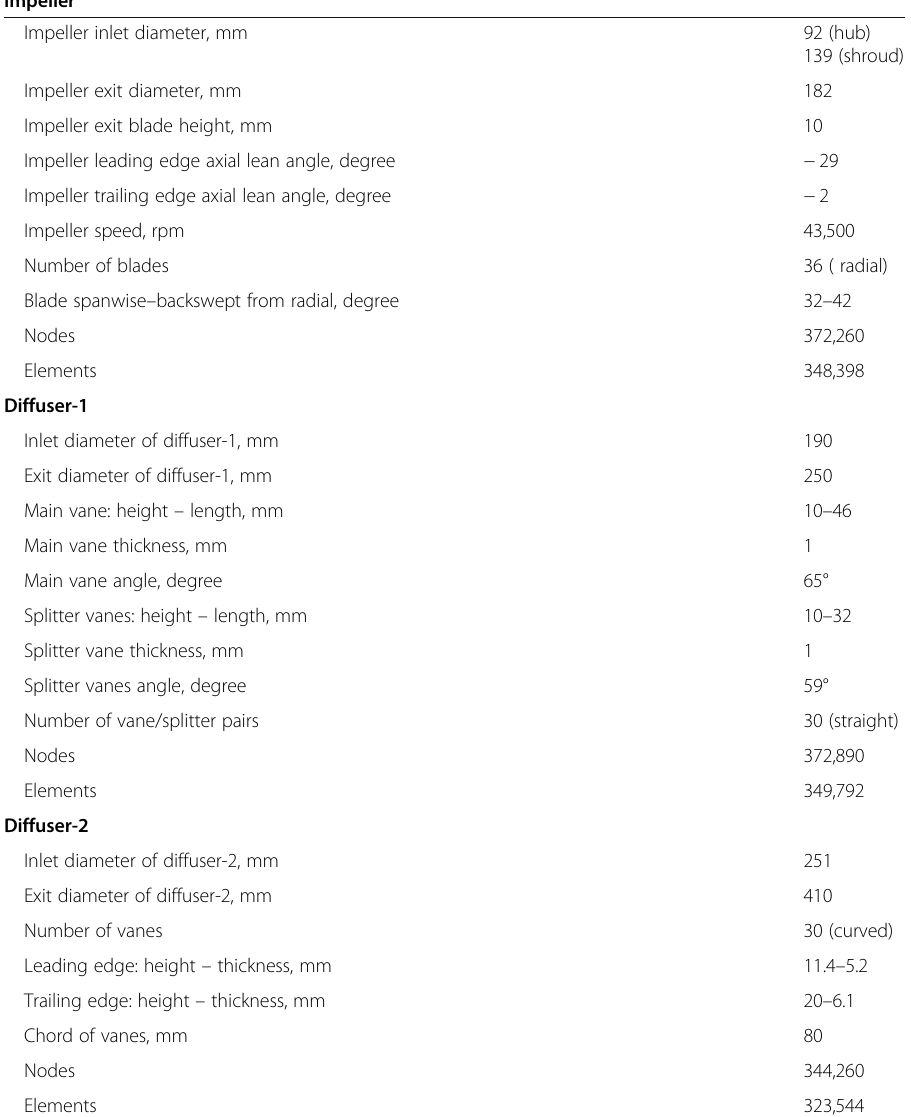
Table 1 Main dimensions and grid structure of centrifugal compressor components